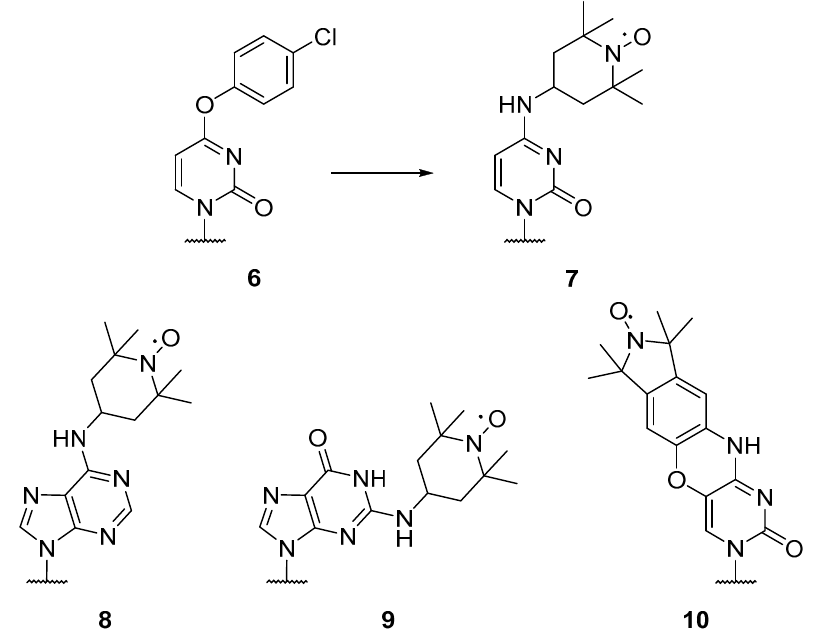
Figure 2. Spin labelled RNA